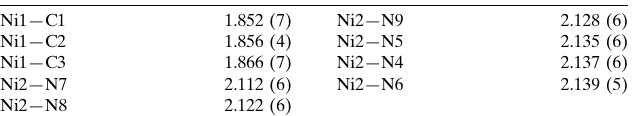
Selected bond lengths (A˚ ).